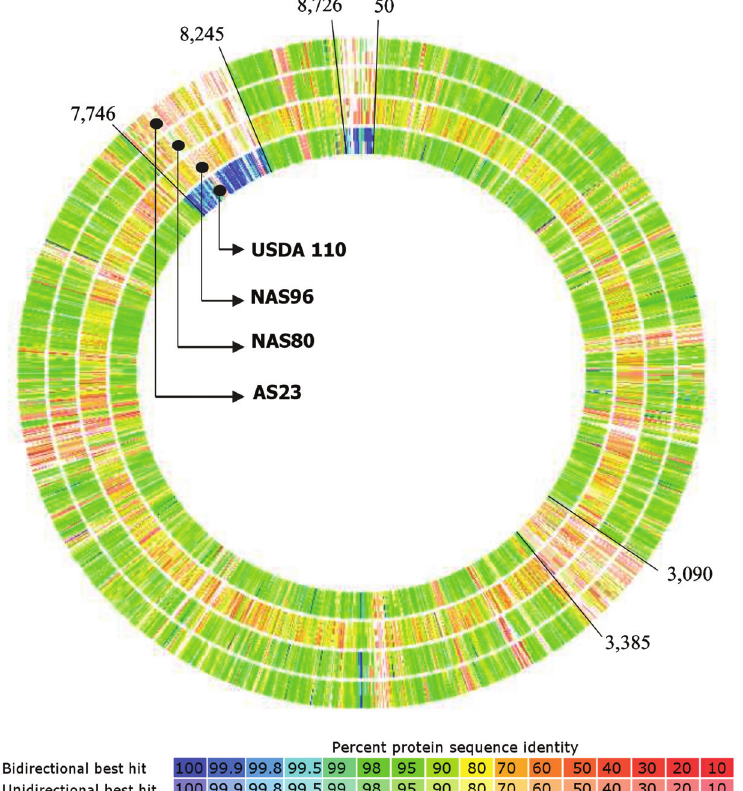
Figure 2 - Circular heat map representing the genomes of Bradyrhizobium AS23, NAS80, NAS96, and B. diazoefficiens USDA 110 in comparison with thereferencestrain B.japonicum USDA6genome.GenomeoftheUSDA6strainisnotshown.Theregionswherethegeneshadlessthan80%ofsimilar- ity were considered significantly